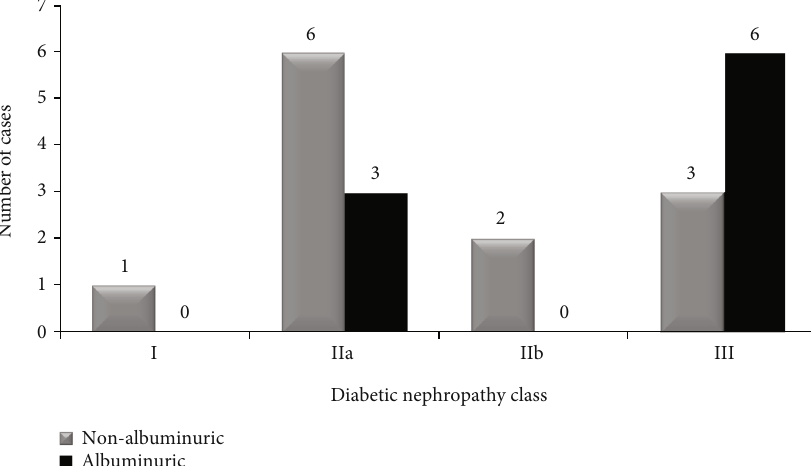
Figure 3: The number of cases in the di ff erent classes of glomerular diabetic nephropathy lesions. Glomerular lesions in all diabetic patients. We show albuminuric (black) against nonalbuminuric (gray) ( n = 21 )